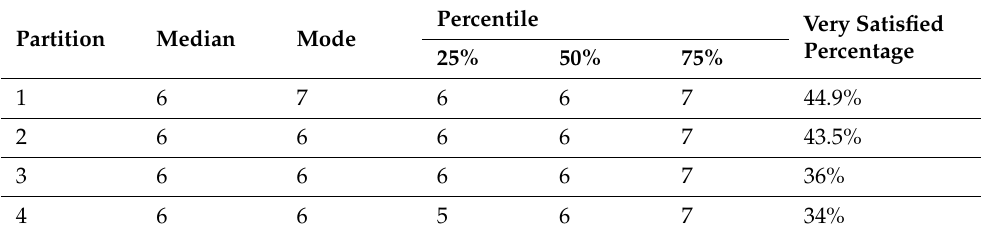
Table 4. Greening landscape data statistics.